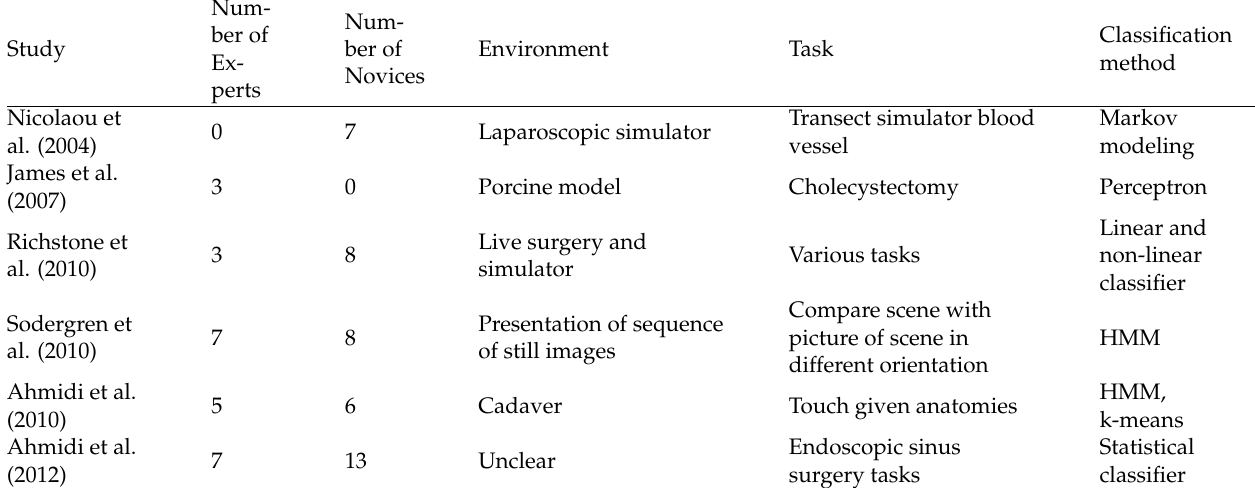
Studies applying classifiers for skill assessment, listing the number of experts and novices that went into the analysis, the environment under which the eye movements were collected, the task participants were performing and the type of classifier being